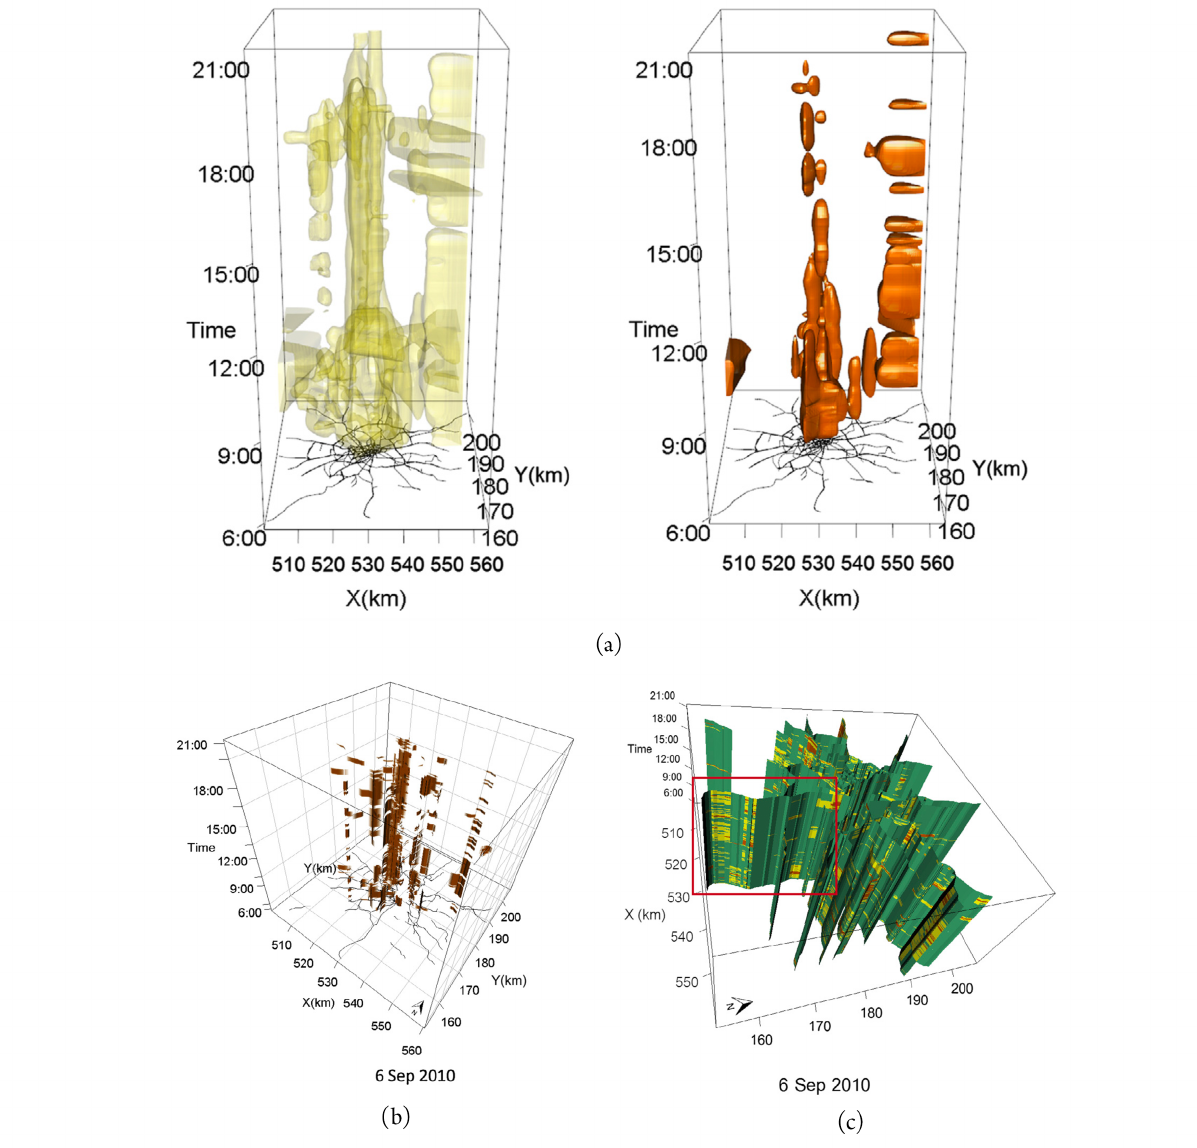
Figure 4. The isosurface ( a ), network-constrained isosurface ( b ), and the wall map ( c ) visualization techniques for exploring congestion evolution